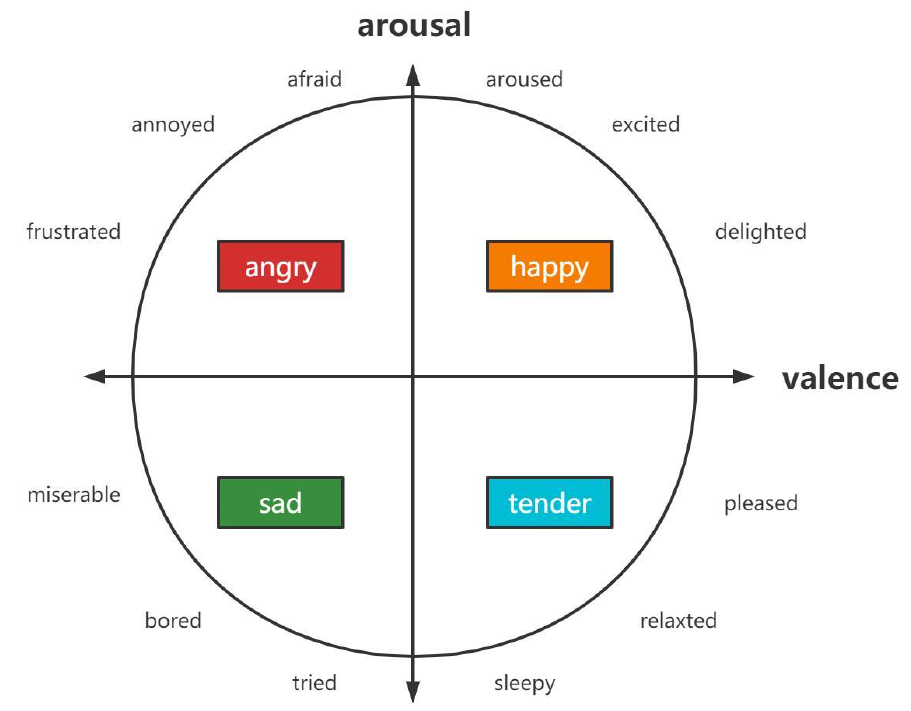
Figure 1. Two-dimensional emotion plane: valence vs. arousal.